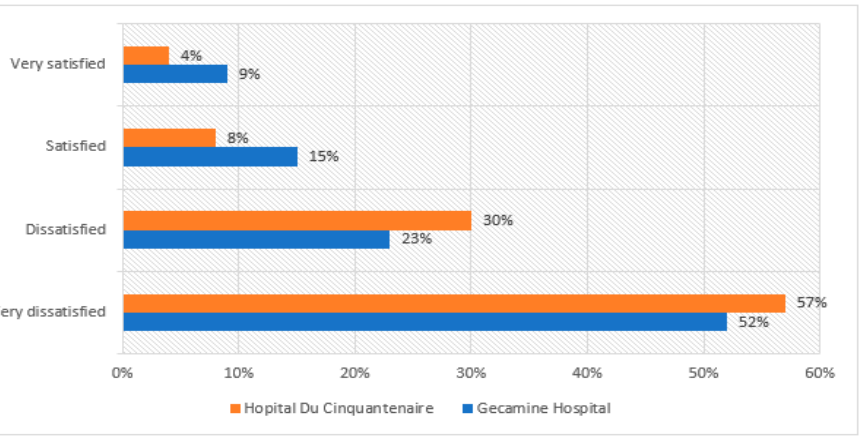
Figure 3. Results from the questionnaire regarding satisfaction with the noise level in the patients’ wards.